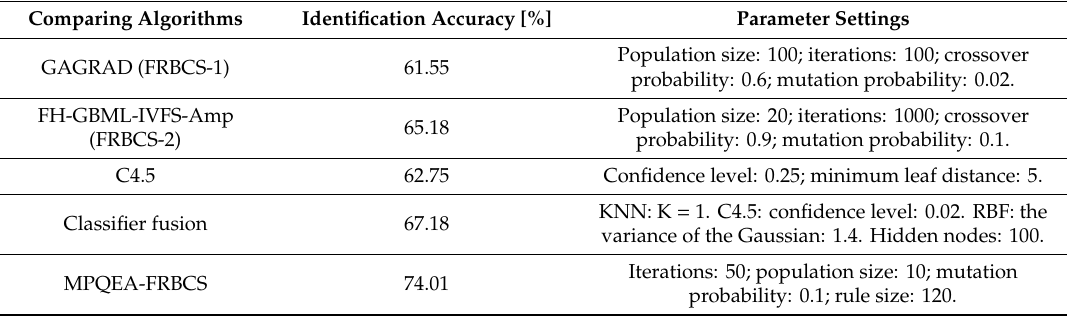
Table 8. Parameter settings and identification accuracy.